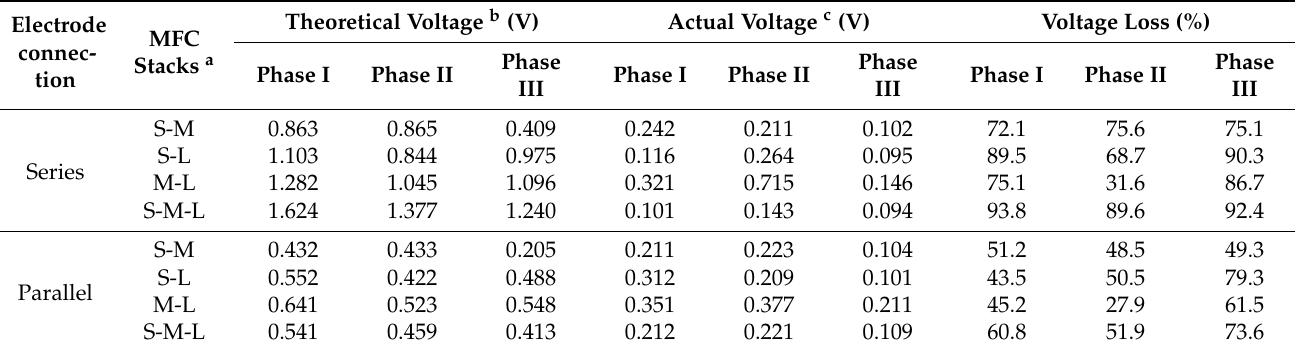
Table 3. Theoretical and actual measured voltage productions and voltage loss in a stacked system according to the electrode connection methods at phases I, II, and